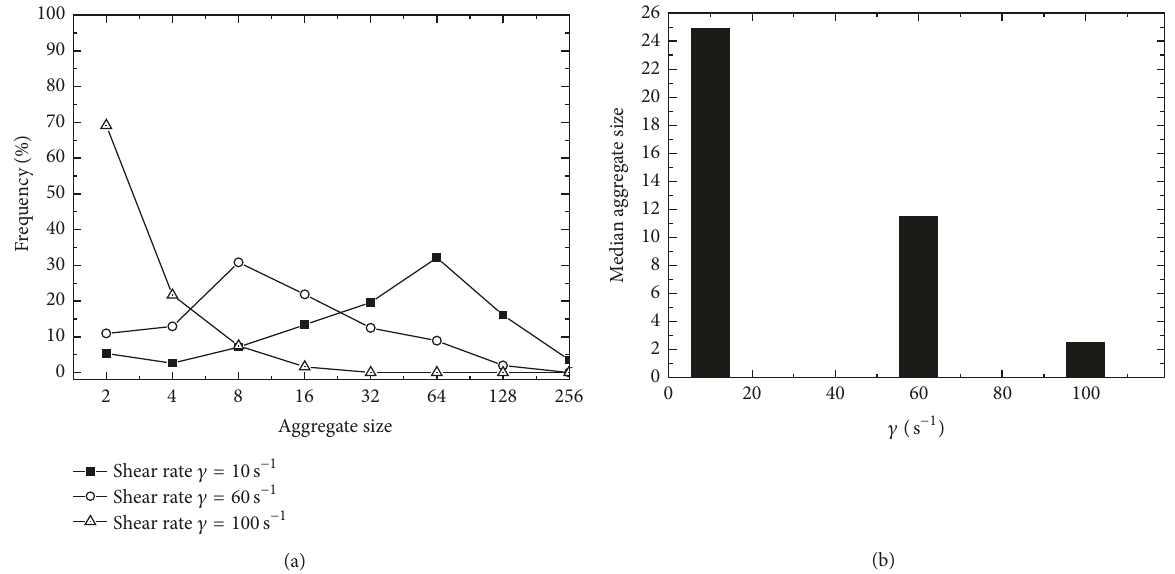
Figure 12: Aggregate sizes of RBCs based on simulation results. (a) Aggregate size distributions at equilibrium states. (b) Median aggregate size under 3 different shear